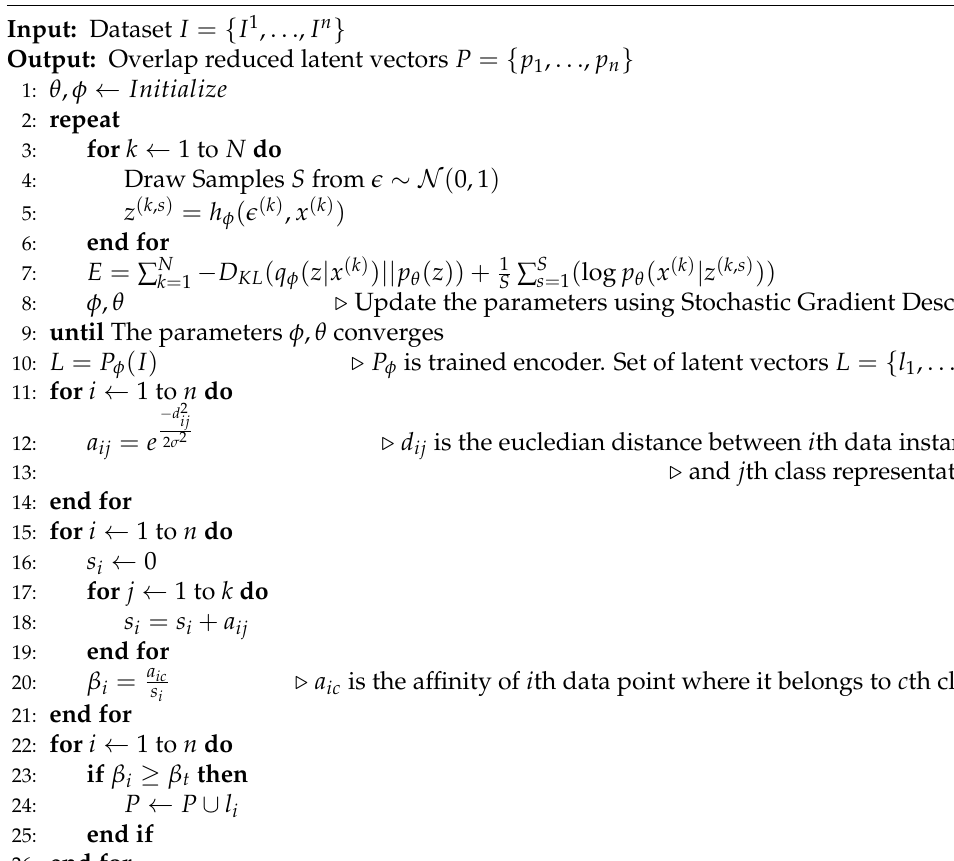
Algorithm 1 Residual Variational Autoencoder (RAV) based Affinity-based Overlap Re- duction Technique